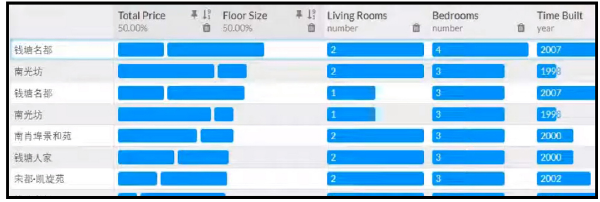
Fig. 5 LineUp. Bars for the first two attributes are stacked by users. Reproduced with permission from Ref. [100], c (cid:13) ACM